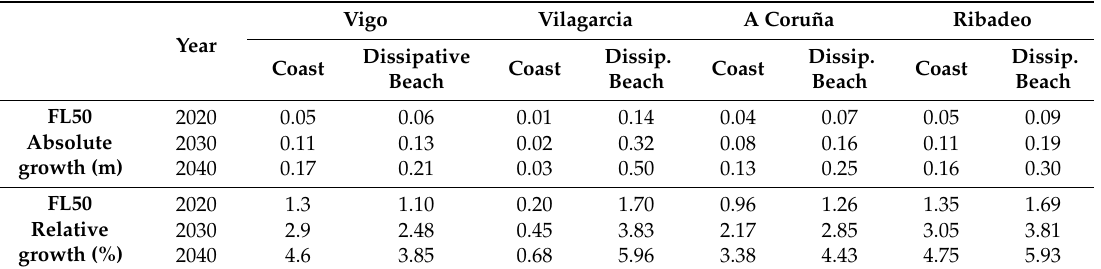
Table 5. FL50 absolute and relative growth at coast and dissipative beaches in Galicia.